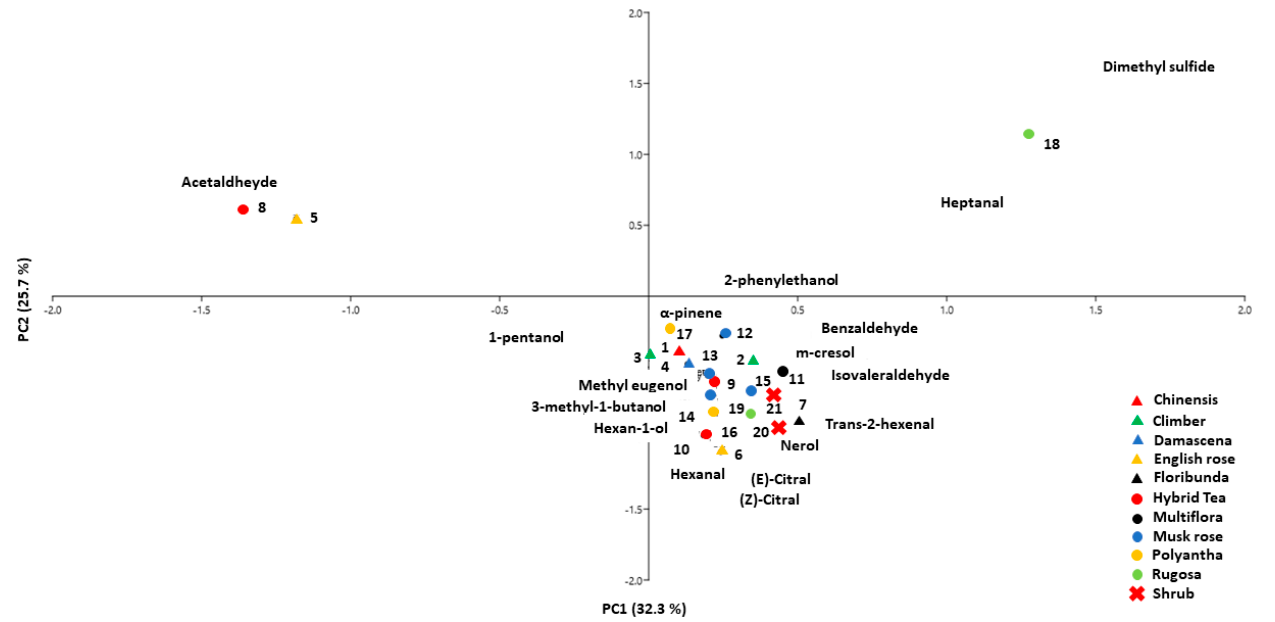
Figure 5. Principal component analysis (PCA)-biplot of the studied garden rose genotypes and volatile compounds emitted by pollen. Numbers indicated the garden rose genotypes as listed in Table 1.